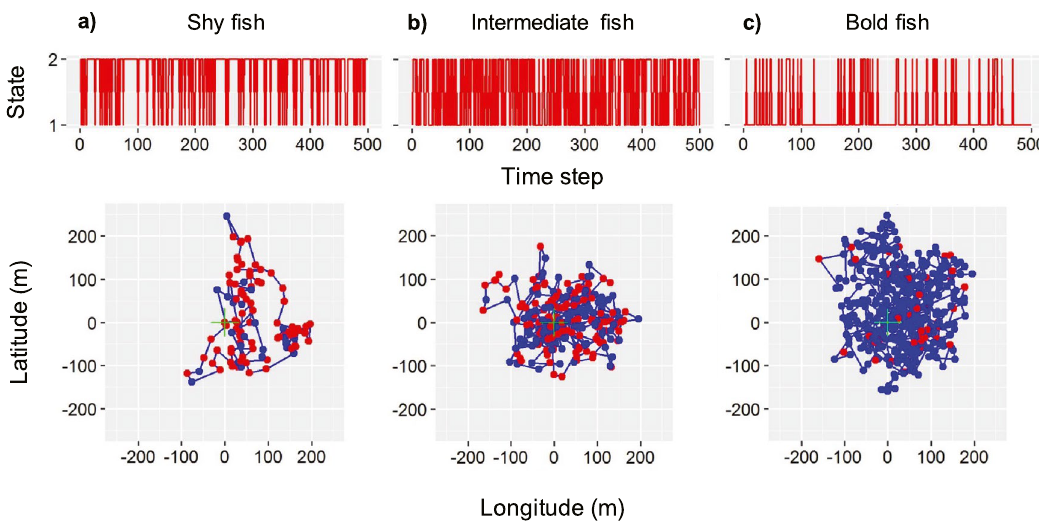
Figure 3. Simulation of 1000 time steps of three fish moving according to the two-state movement model with different probabilities of transition. Graphs on top show the Markovian-based transitions between state 1 (swimming) and state 2 (hidden) over time for each individual (shy, intermediate and bold). The scatter plots below represent the movement pattern. Red dots denote the location of a hidden individual while blue dots and lines represent individuals swimming and their path. The transition between states was generated using the transition matrix in Eq. (1). ( a ) graphs obtained from simulating data on shy fish (individuals that tend to remain in state 2, hidden); ( b ) simulated data on intermediate fish (individuals that do not show a preference for a state); and ( c ) simulated data on bold fish (individuals that tend to remain in state 1,